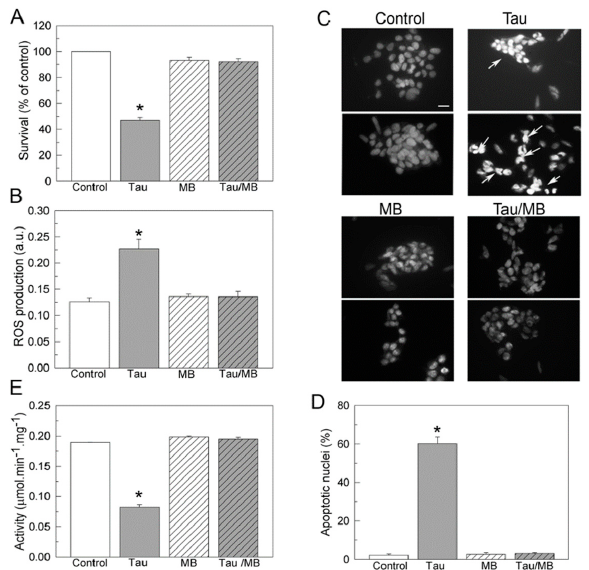
Figure 5. Effects of tau and MB on cell viability ( A ), ROS production ( B ), apoptosis ( C , D ), and Ca 2+ -ATPase activity ( E ), in human SH-SY5Y neuroblastoma cells. Cells were growing in the absence or presence of 10 nM tau, without or with 10 nM MB, as detailed in Materials and Methods. ( A ) Cell viability was measured in control and treated cells after 1 h incubation with 150 µg/mL MTT. The viability of cells treated with tau decreased to 50% of that of the control group, but increased to the same control level when co-treated with tau and MB. Values are expressed as the percentage of the untreated control cells and represented as mean ± SE of at least five independent experiments. ( B ) ROS production was assayed in control and treated cells after 30 min incubation with 40 µM H 2 DCFDA (ROS sensitive fluorescent dye). ( C ) Ca 2+ -ATPase activity was assayed in 10 µg of membranes prepared from SH-SY5Y cells, previously treated as indicated above. The total Ca 2+ -ATPase activity was measured as indicated in the method. Data represent mean ± SE of four experiments performed in duplicate from three cell cultures. ( C ) Fluorescence microscopy of DAPI staining in controls and cells incubated with tau or/and MB. The panel shows representative images of apoptotic nuclei identified by condensed chromatin and nuclear fragmentation (white arrows). Scale bar: 10 µM ( D ) Quantification of apoptotic nuclei with respect to the total number of seeded cells in each type of culture. Values are mean ± SE of ten images per coverslip, obtained from four independent cultures. * p < 0.001 vs control cells.